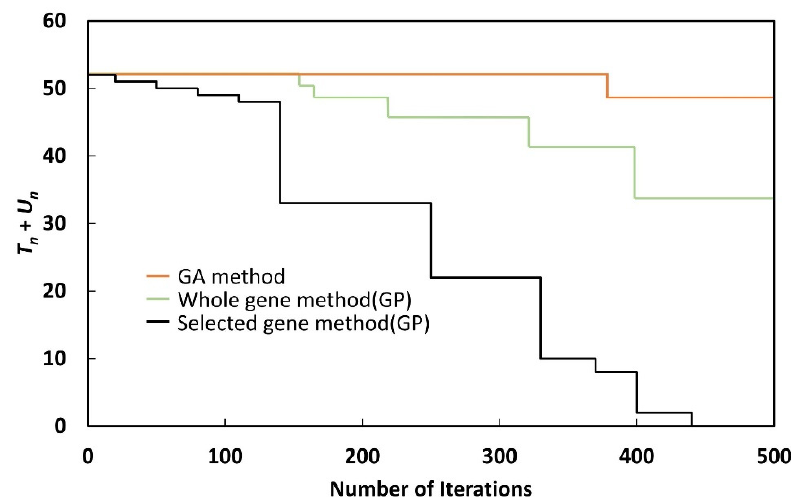
Figure 13. GP results for the minimized fitness function (2022).